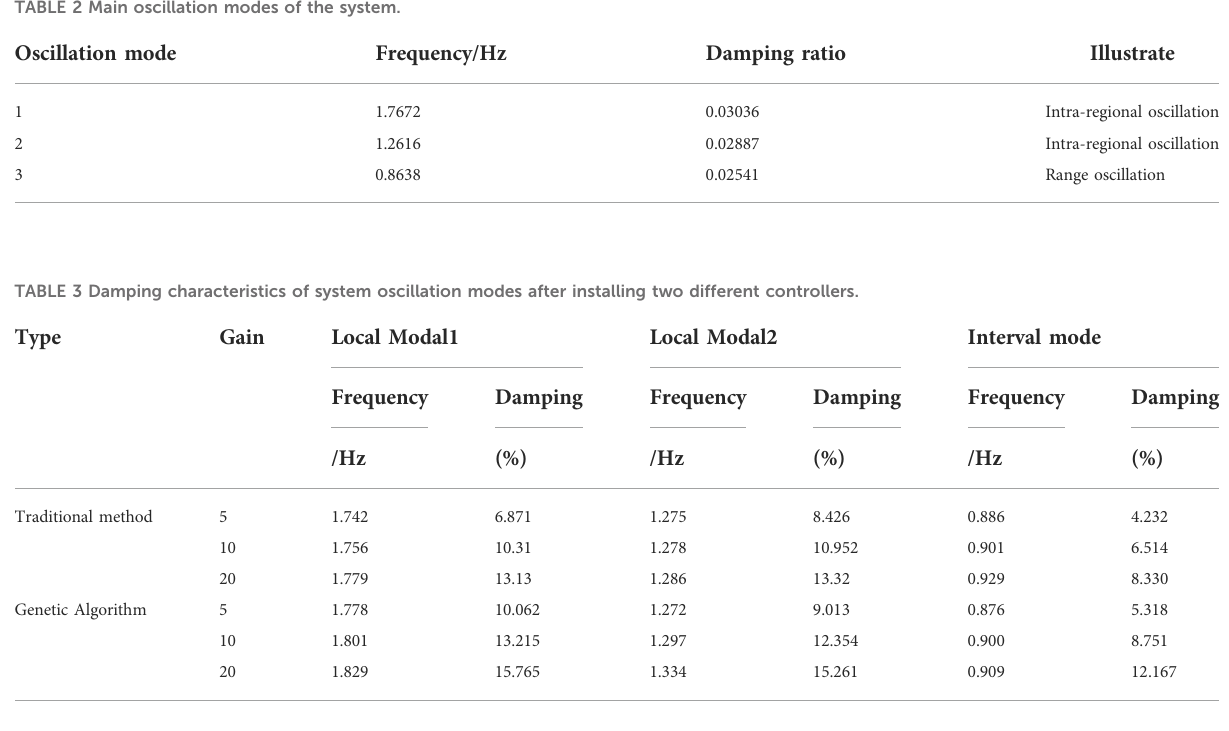
TABLE 2 Main oscillation modes of the system.